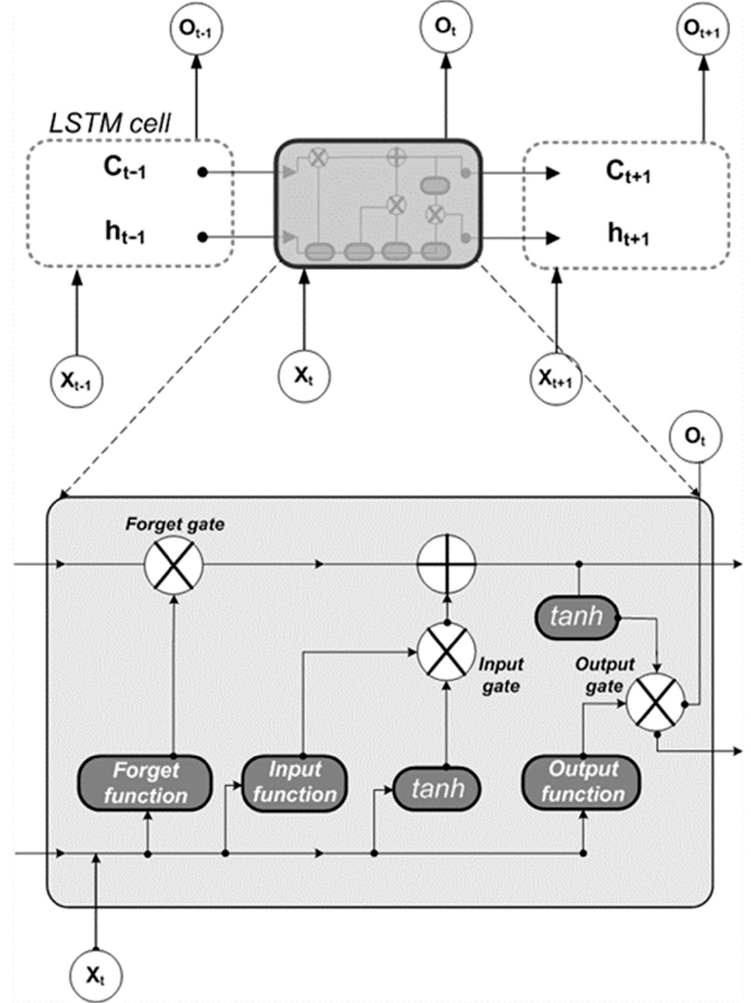
Figure 3. Conceptual diagram of LSTM model.